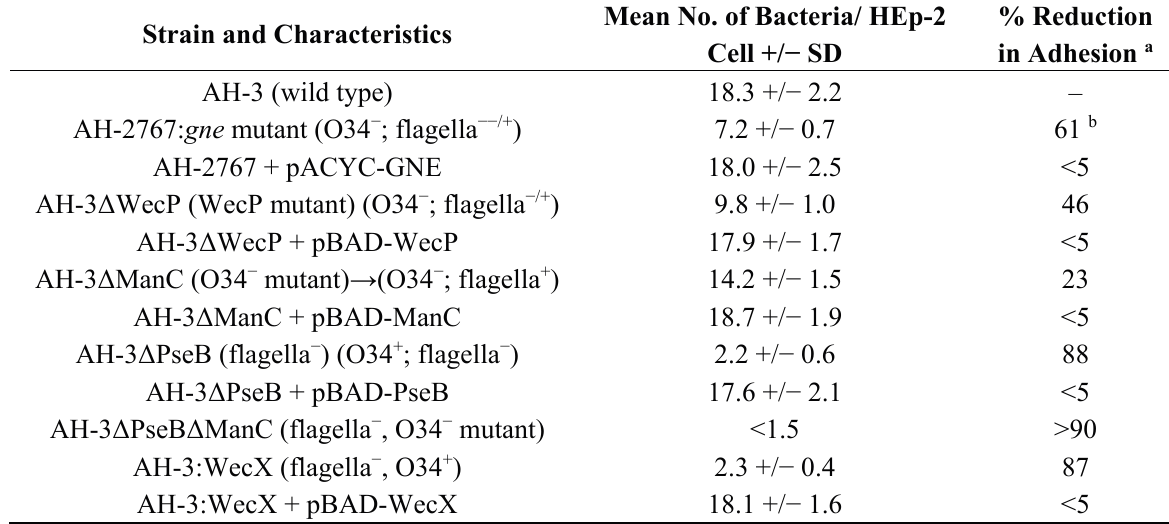
Table 1. Adhesion of different A. hydrophila serotype O34 strains to HEp-2 cells as described in Experimental section. Values presented are mean +/ − SD from three independent experiments carried out in duplicates or triplicates ( n = 6 or n = 9). Mean No. of Bacteria/ Strain and Characteristics